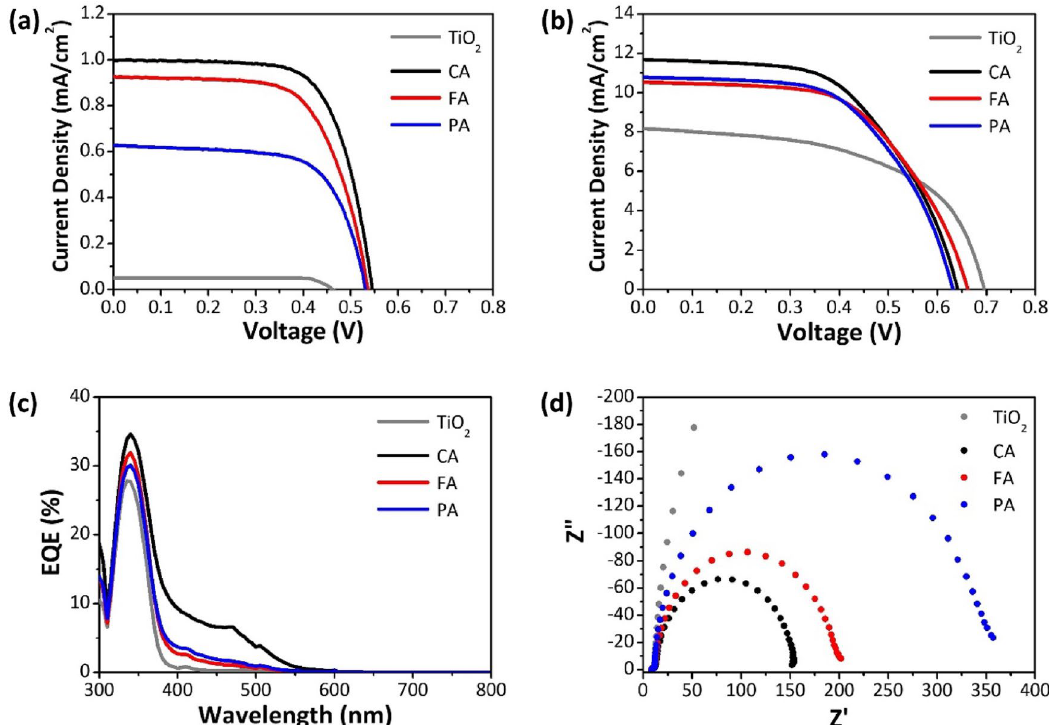
Figure 4. J-V characteristics under ( a ) one-sun illumination (AM 1.5G, 100 mW/cm 2 ) and ( b ) UVA radiation (365 nm, 115 mW/cm 2 ), ( c ) EQE of DSSCs sensitized with CA, FA, and PA, ( d ) Nyquist plots of DSSCs under one-sun illumination. Cell V oc (V) J sc (mA/cm 2 ) FF (%) PCE (%) One sun illumination (AM 1.5G, 100 mW/cm 2